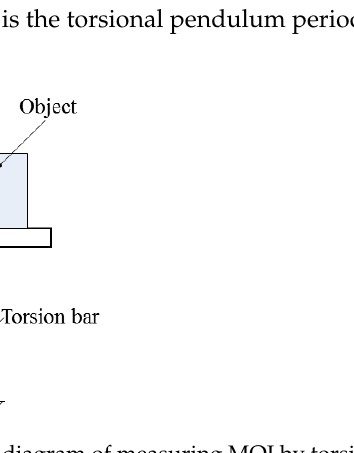
Figure 4. Schematic diagram of the measurement principle of the torsional pendulum period. 2.2. The Mechanical Structure In this section, the design of an integrated mass property measurement system based on the multi-point weighing and torsion pendulum method is described, along with the design and implementation of a new type of measurement function-switching mechanism, which can achieve the function of multi-parameter measurement and, at the same time, overcome the defects of current integration equipment. In the case of not us- ing the coordinate measuring equipment outside the system, the relative position of the sensor and the test object is kept fixed to ensure the accuracy of mass property meas- urement. Furthermore, a multi-station switching device was developed to provide an expandable interface for the matching tooling of the test object with different dimensions and to provide the horizontal and vertical measurement functions for the test object, as shown in Figure 5. Through the function of quadrant positioning, unnecessary lifting and repeated installation links in the measurement process were reduced to the maxi- mum extent, providing a new idea for the measurement of mass properties of large air- craft.